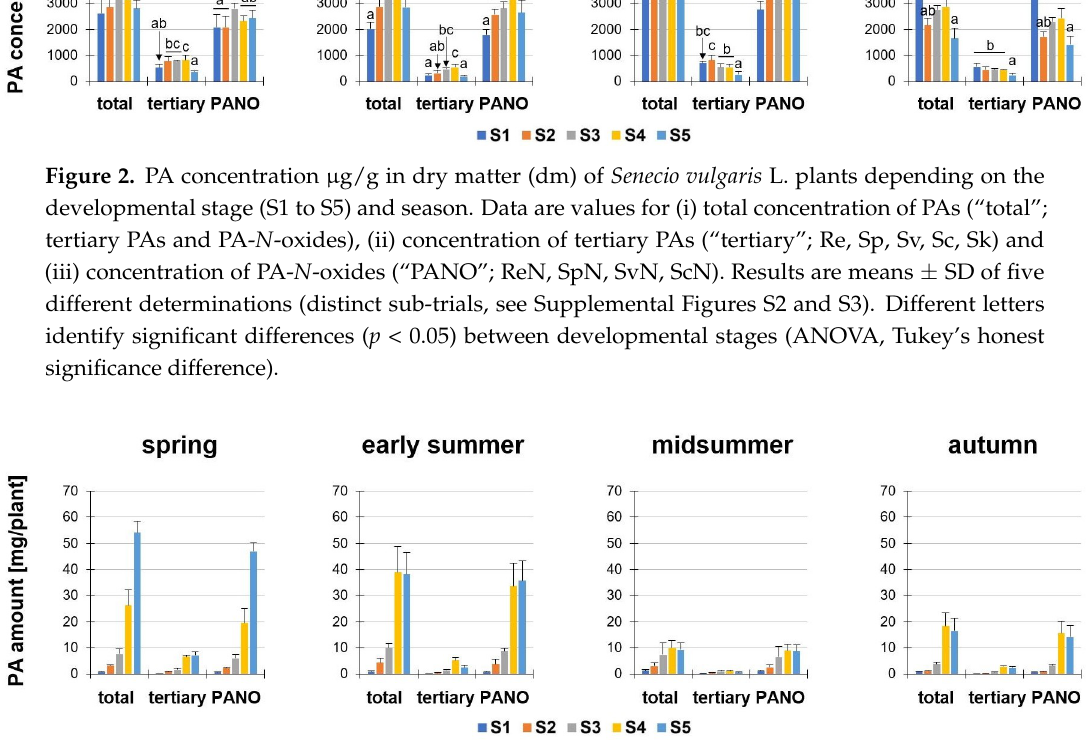
Figure 3. PA amount of Senecio vulgaris L. (mg/plant) depending on the developmental stage (S1 to S5) and season. Data are values for (i) total amount of PAs (“total”; tertiary PAs and PA- N -oxides), (ii) amount of tertiary PAs (“tertiary”; Re, Sp, Sv, Sc, Sk) and (iii) amount of PA- N -oxides (“PANO”; ReN, SpN, SvN, ScN). Results are means ± SD of five different determinations (distinct sub-trials, see Supplemental Figures S2 and